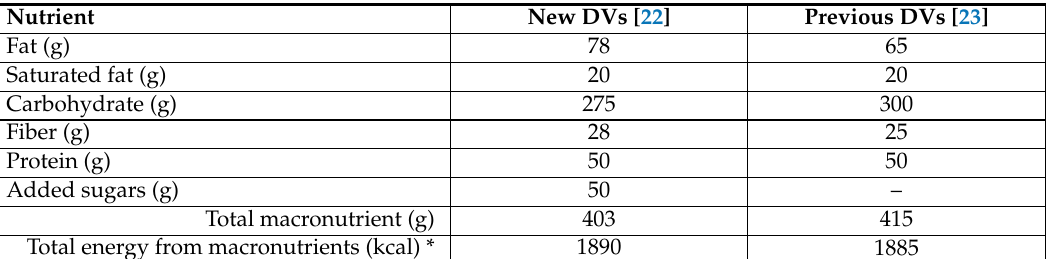
Table 1. New and previous daily values (DVs) from the daily reference values for males and females aged 4 years or